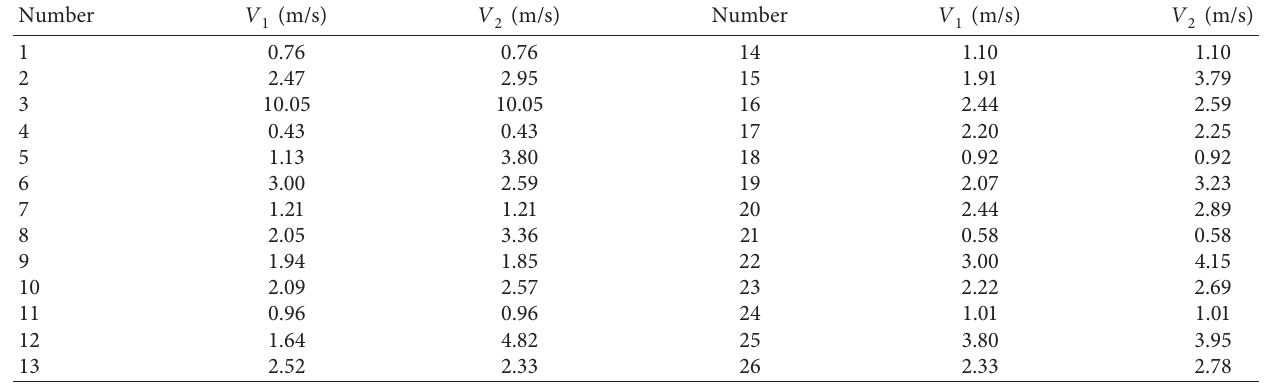
Table 3: The comparison of spectral velocity with or without rigid body motion correction.